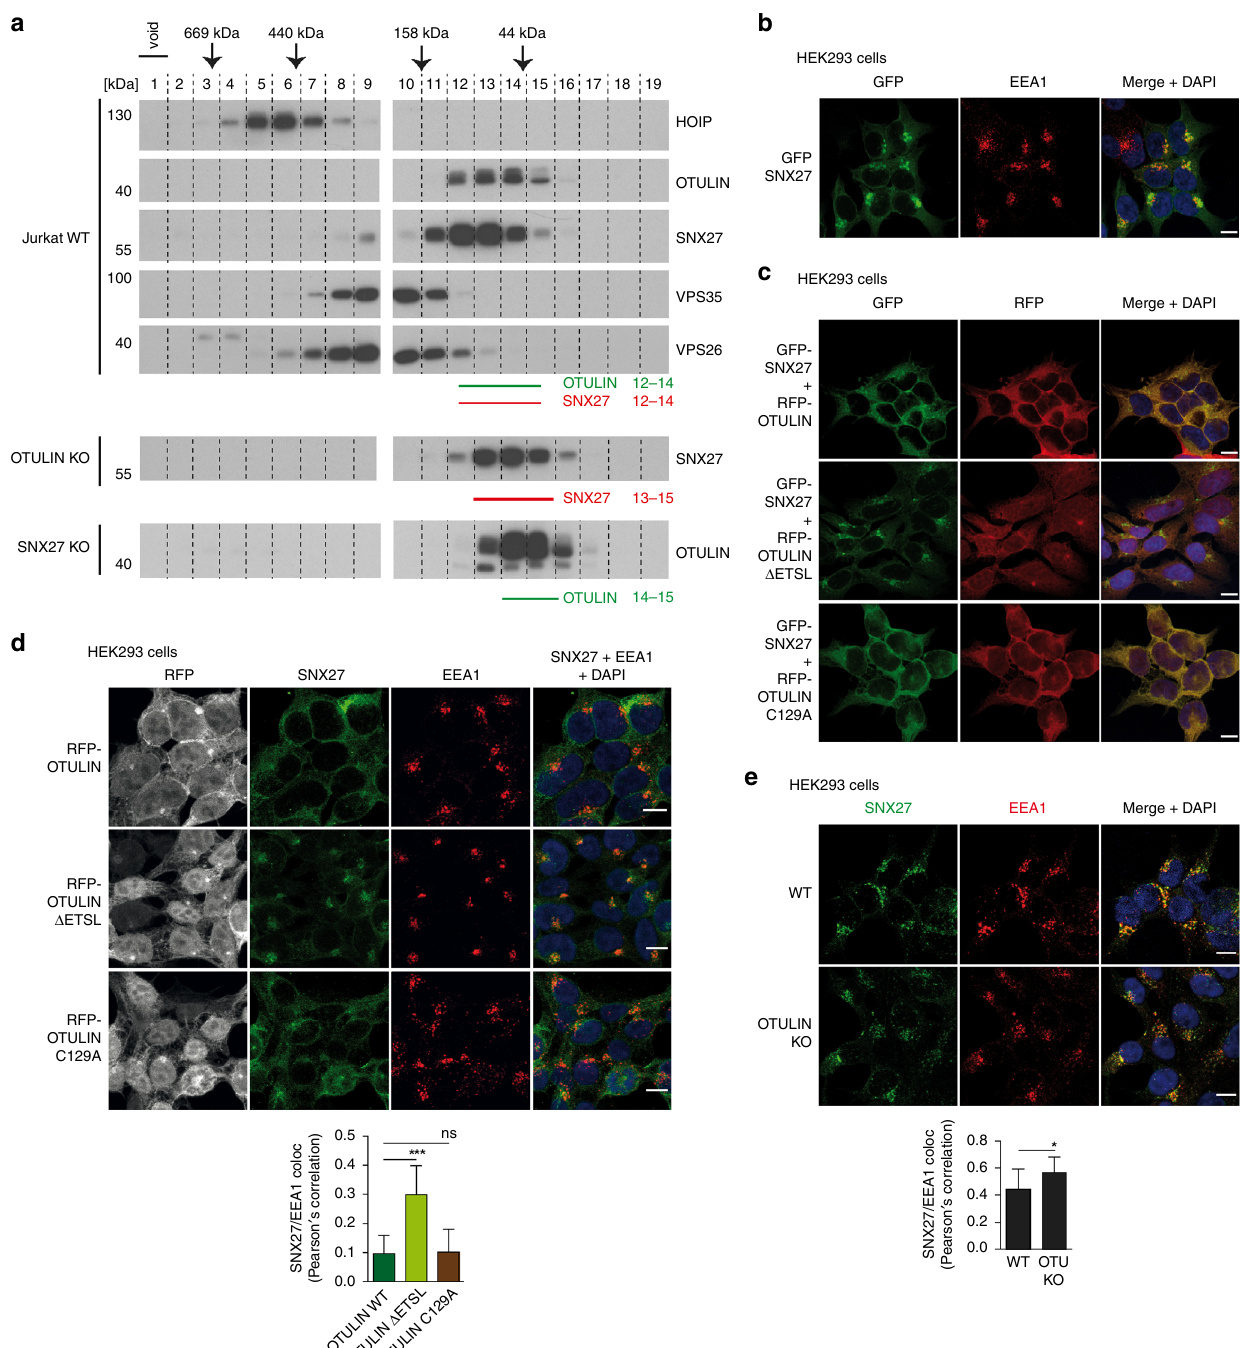
Fig. 6 Binding of OTULIN antagonizes SNX27 association with early endosomes. a Co-elution of endogenous OTULIN and SNX27 was analyzed by size exclusion chromatography. Upper panels: cell lysates of parental Jurkat T cells were fractionated using a Superdex 200 column and elution pro fi les of endogenous proteins (OTULIN, SNX27, HOIP, VPS35, and VPS26) were determined by WB. Lower panels: determination of elution pro fi les of endogenous SNX27 and OTULIN in OTULIN and SNX27 KO Jurkat T cells, respectively. Peak elution of molecular weight standards is depicted at the top. b HEK293 cells virally transduced with GFP-SNX27 (green) were stained for early endosomes using anti-EEA1 antibody (red) and co-localization was analyzed by confocal microscopy. c HEK293 cells were co-transduced with GFP-SNX27 (green) and RFP-OTULIN WT, Δ ETSL or C129A (red). Localization of proteins was analyzed by confocal fl uorescence microscopy. d HEK293 cells virally transduced with RFP-OTULIN WT, Δ ETSL or C129A (gray) were stained for endogenous SNX27 (green) and EEA1 (red) and localization was analyzed by confocal fl uorescence microscopy. e WT or OTULIN KO HEK293 cells were stained for endogenous SNX27 (green) and EEA1 (red) and localization was analyzed by confocal fl uorescence microscopy. Co-localization in d and e was quanti fi ed by determining Pearson ’ s correlation using at least 12 pictures and imaging more than 100 cells for each condition. Graphs depict the mean ± SD. Two-tailed p -values: ns not signi fi cant, * p ≤ 0.05, *** p ≤ 0.001 by unpaired t -test. Scale bars: 10 µ m. Source data are provided as a Source Data fi